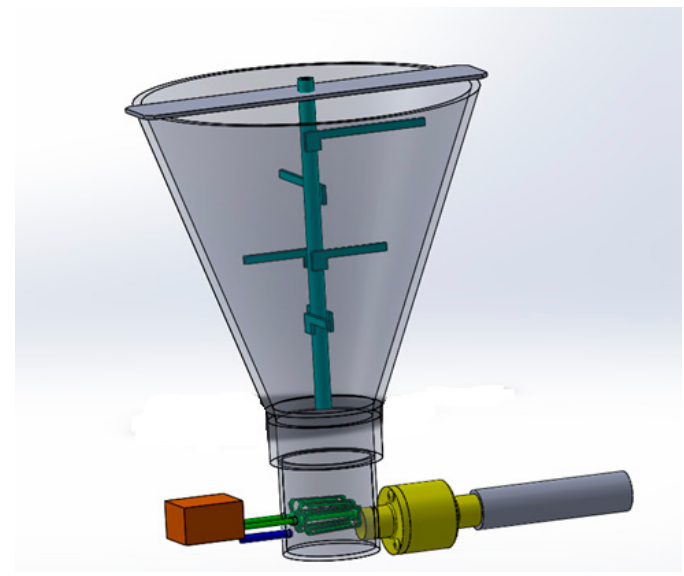
Figure 6. Schematic design of the fiber dispenser (feed plus conveying) unit.